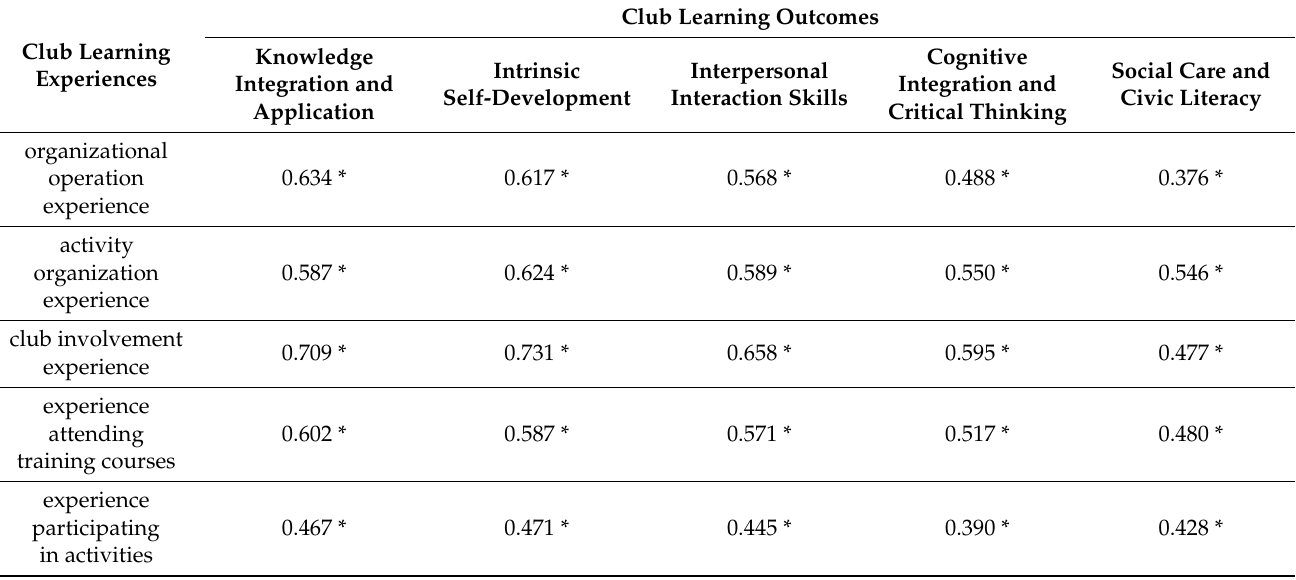
Table 5. Relevance of the club learning experience to the club respondents’ learning